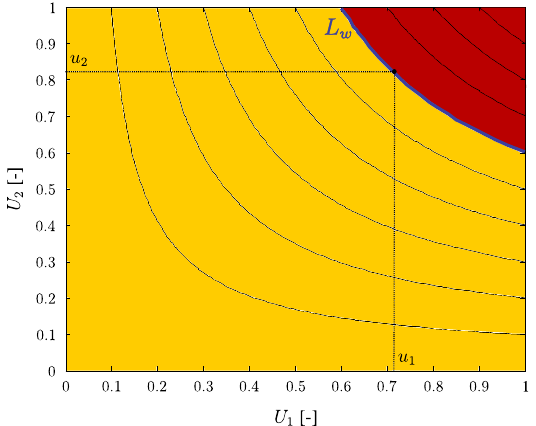
Figure 4. Level curves (black) of a bivariate copula, the region (yellow) corresponding to the probability of observing a less (subcritical) event and the region (red) corresponding to the probability of observing a worse (supercritical) event than an event located on the blue level